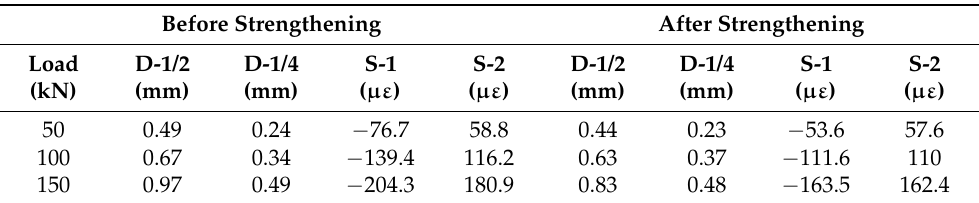
Table 4. Deflection and strain of prestressed hollow slab before and after strengthening with steel